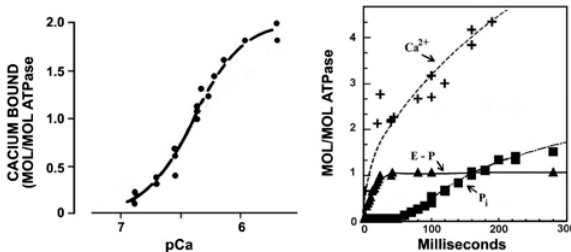
Figure 3a. Ca 2+ binding to SR ATPase under equilibrium con- ditions, in the absence of ATP. The stoichiometry of binding is 2 Ca 2+ per ATPase, with a binding constant of 2.3 x 10 6 M -1 , and high cooperativity. 9 Figure 3b. Pre-steady state activity of SR vesi- cles started by addition of ATP in the presence of Ca 2+ . Note that upon addition of ATP a rapid burst of EP formation occurs and, at the same time, 2 Ca 2+ per ATPase become occluded. Steady state Pi production and further Ca 2+ uptake then follow, with a ratio of 2 Ca 2+ per Pi produced.